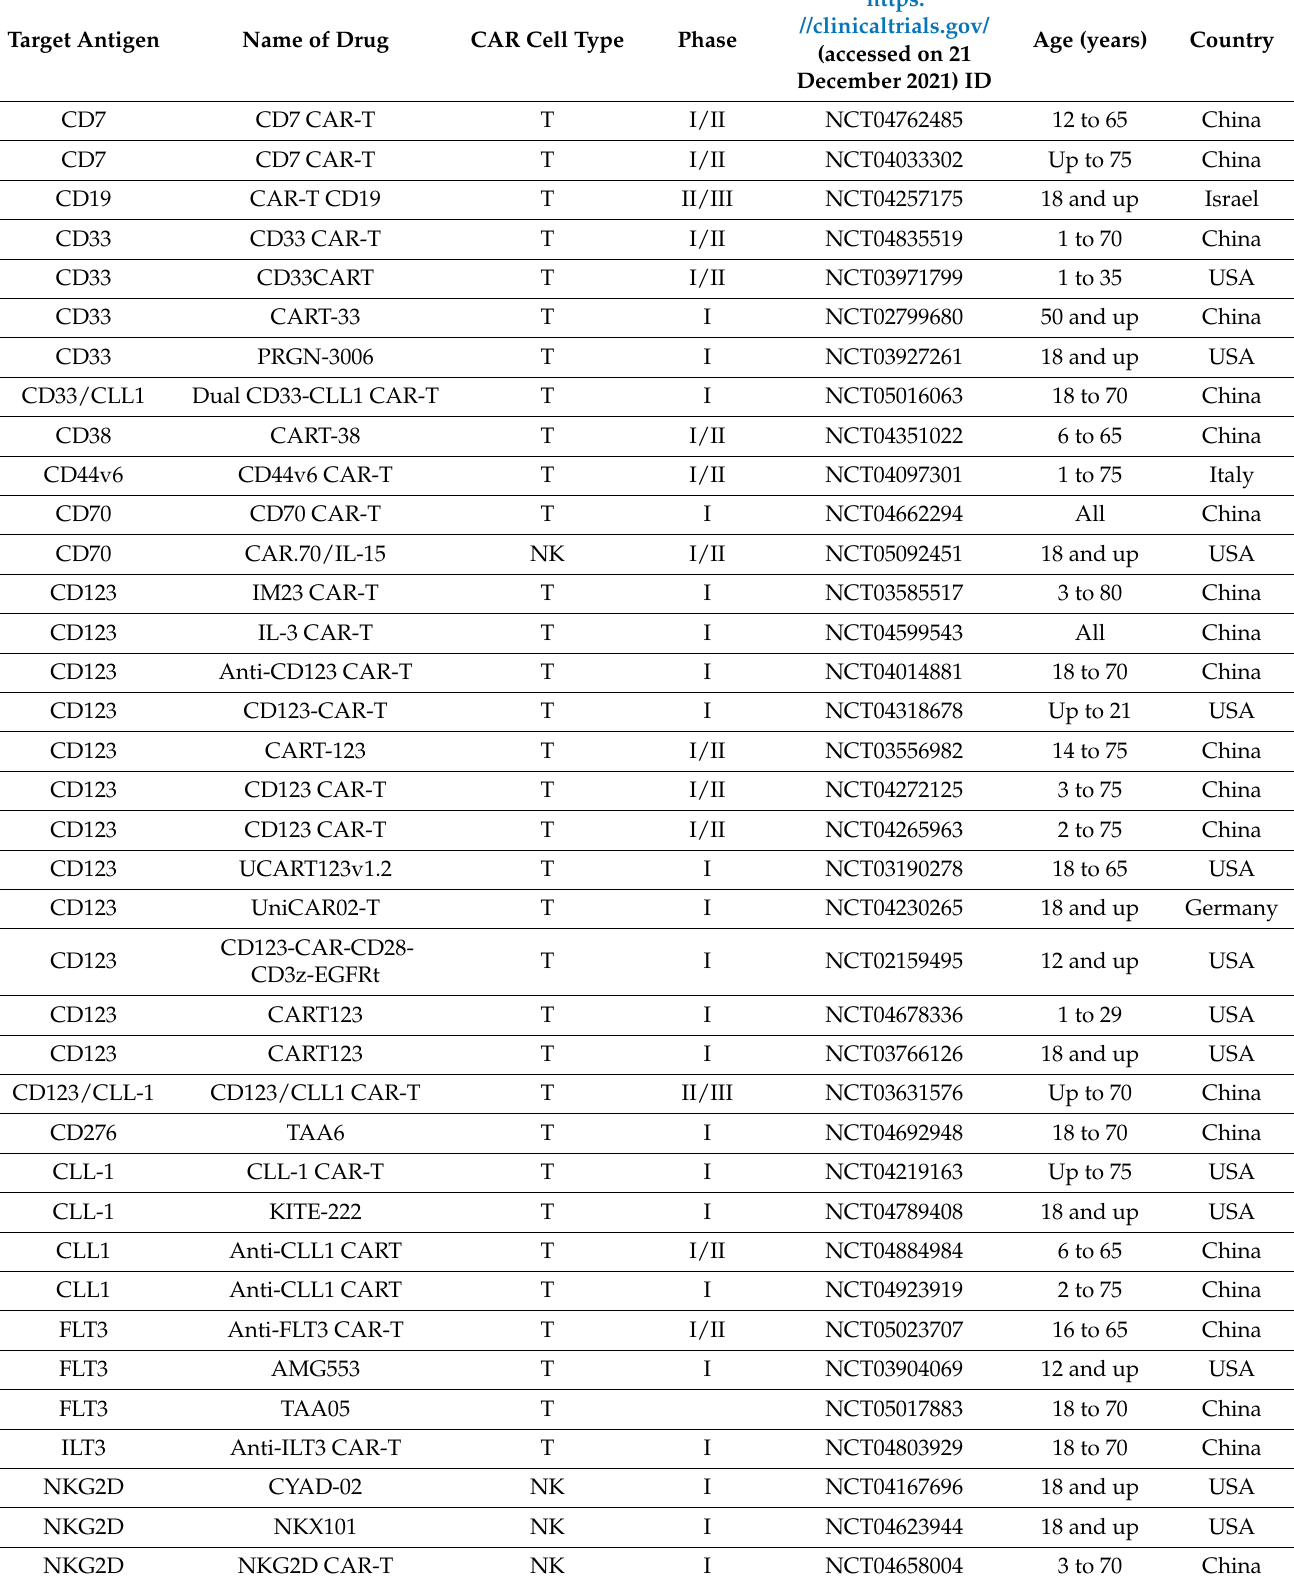
Table 1. Ongoing CAR therapy trials in